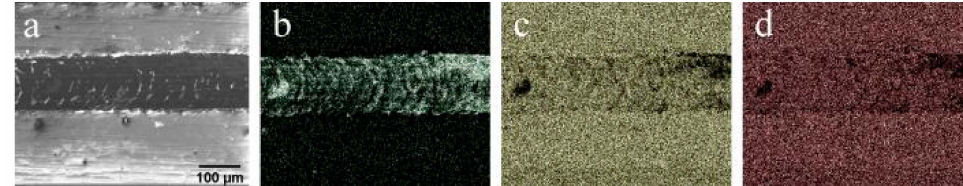
Figure 6. ( a ) SEM image of a track after scratch test for CaP coating on Ti–6Al–7Nb substrate, and EDX mapping of that region showing distribution of ( b ) Ti, ( c ) Ca, and ( d ) P elements.